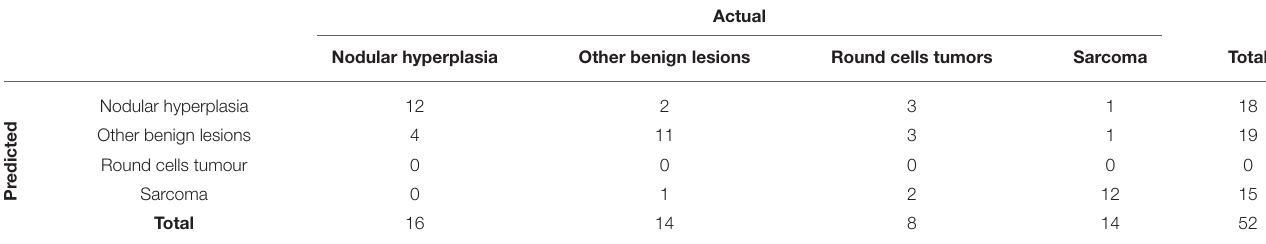
TABLE 4 | Confusion matrix that summarises the performance of the machine learning-based decision tree, giving the number of predicted cases.